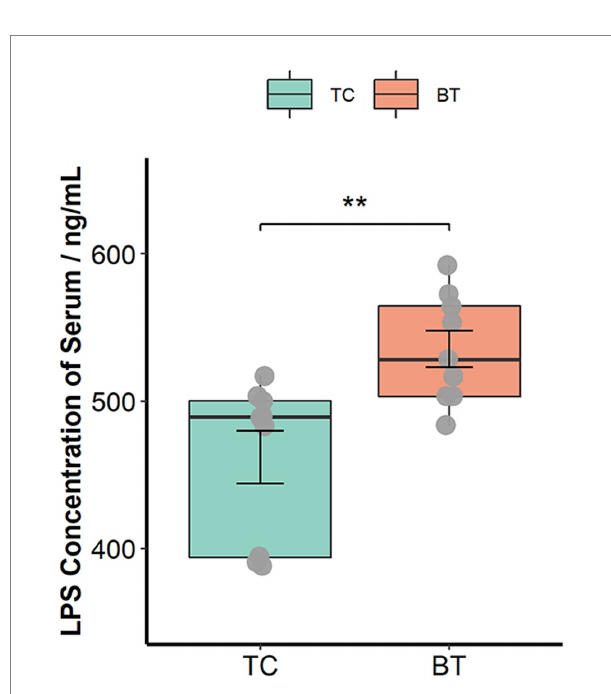
FIGURE 4 LPS concentration of serum was assessed by the ELISA Kit. The values showed in the boxplot presented as means ± SEM, and differences in the figures were marked by “*” and “**” while p < 0.05 and p < 0.01,